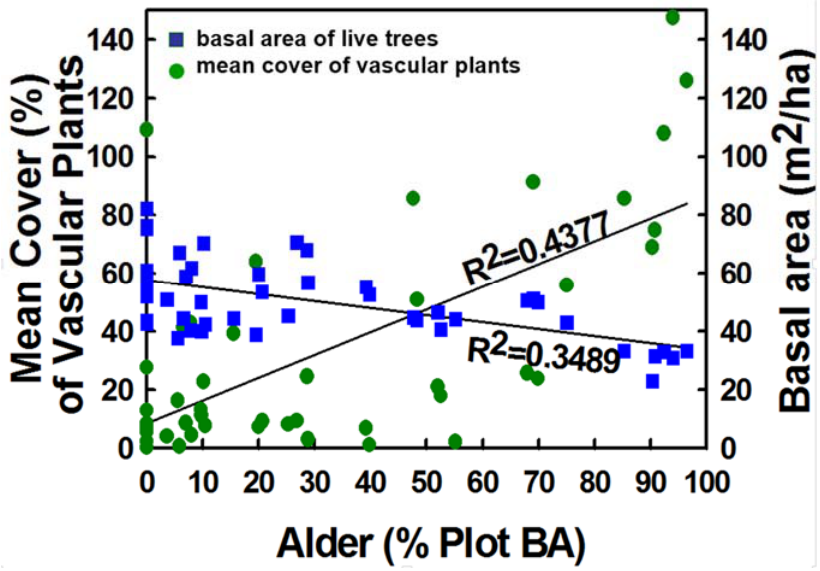
Figure 6. Mean basal area of live trees (combined red alder, western hemlock and Sitka spruce) and mean cover of vascular plants across an x ‐ axis gradient of the proportion of red alder basal area for all plots in the study areas.